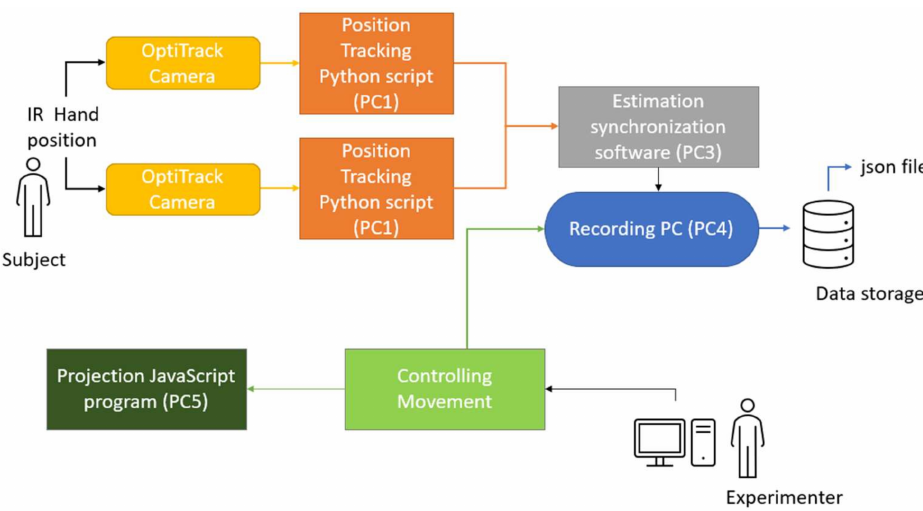
Figure 1. System block diagram implemented for recording hand position movement.